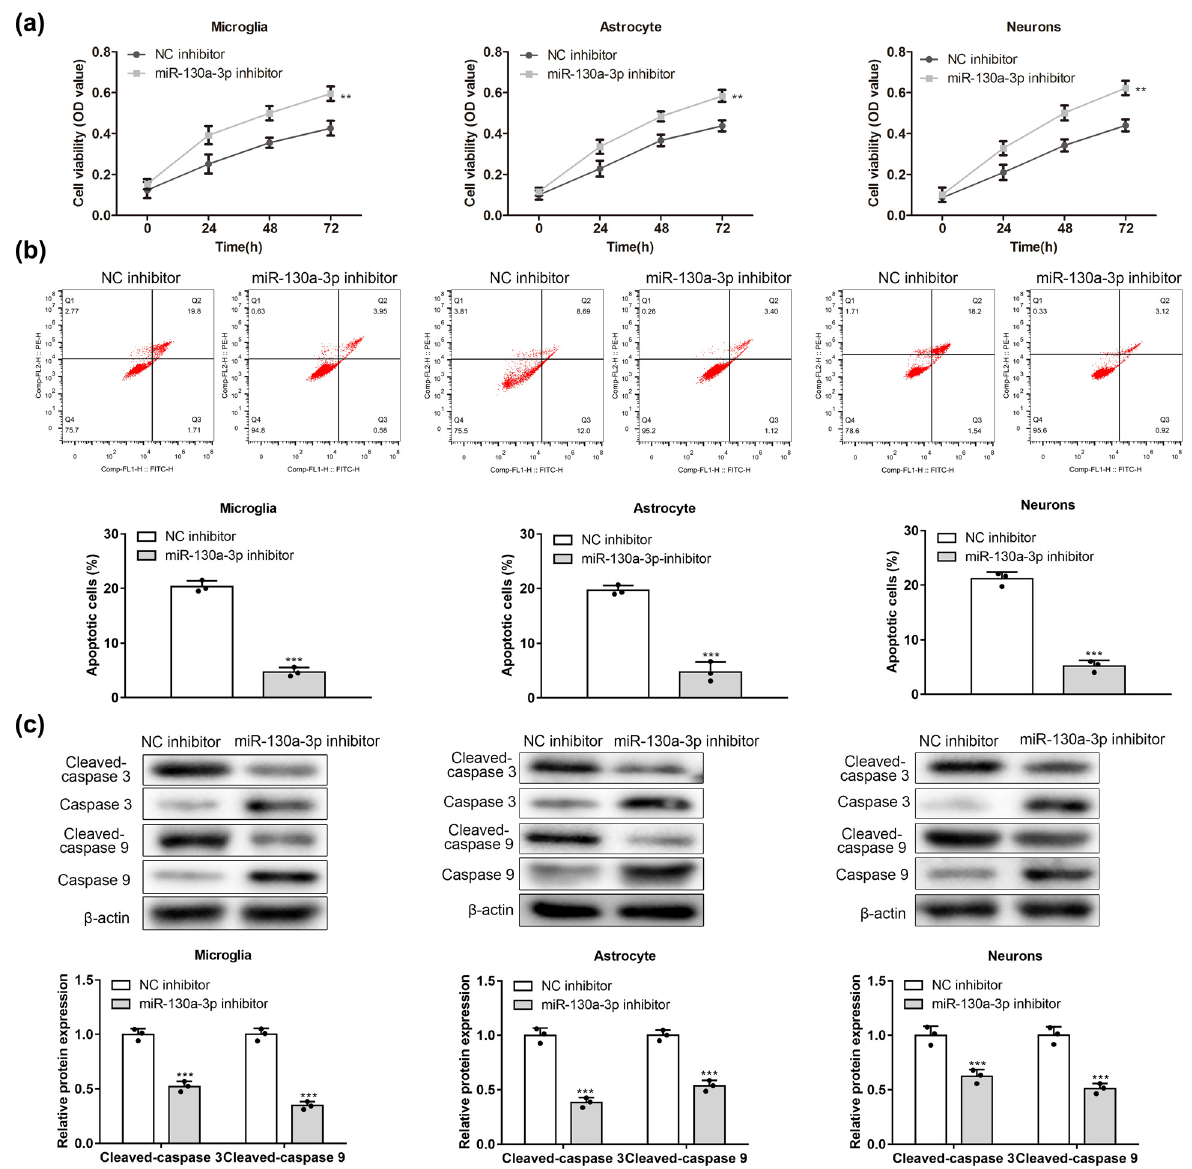
Figure 2: miR - 130a - 3p inhibitor promoted viability and suppressed apoptosis of microglia, astrocytes, and neurons under the HG condition. ( a ) Viability of HG - stimulated microglia, astrocytes, and neurons under the transfection of miR - 130a - 3p inhibitor and NC inhibitor was assessed by CCK - 8 assay. ( b ) Impacts of miR - 130a - 3p inhibitor on HG - induced apoptosis of cells were analyzed by fl ow cytometry. ( c ) E ff ects of miR - 130a - 3p inhibitor on cleaved caspase 3/9 proteins in HG - treated cells were evaluated by western blotting. ** P < 0.01, *** P < 0.001 vs NC